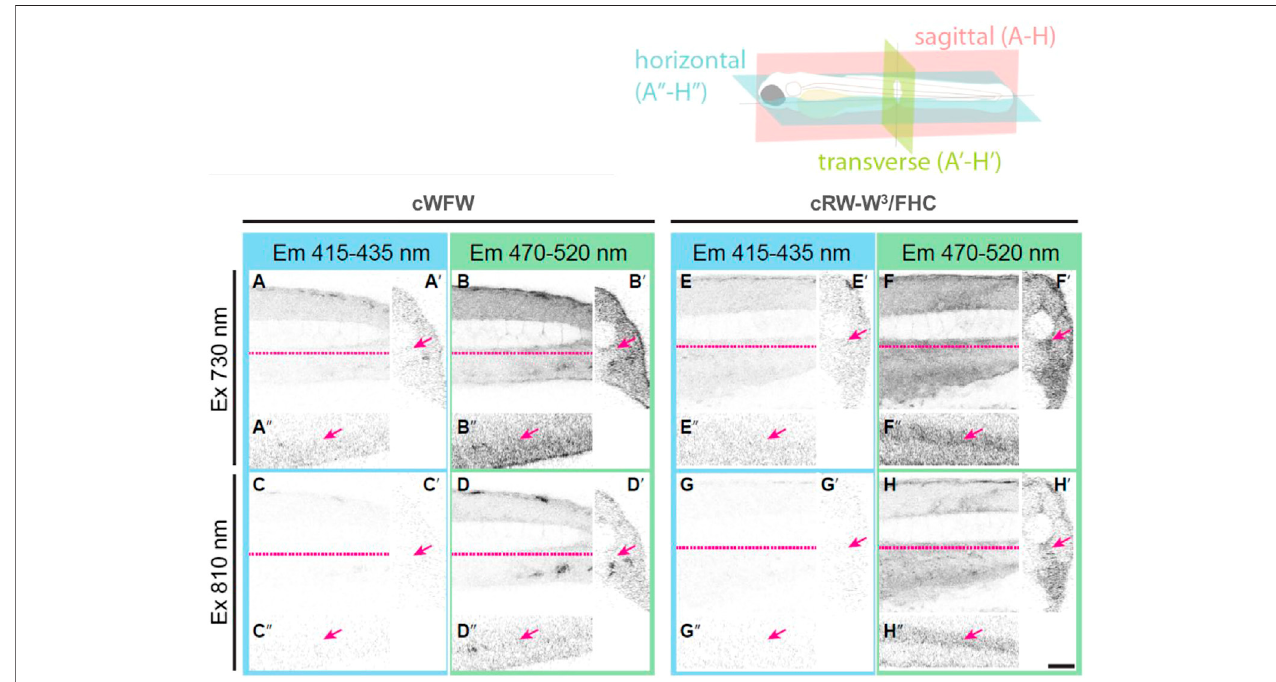
FIGURE 9 | Orthogonal section views from four dpf zebra fi sh embryos injected with either cWFW in PBS (A – D) or cRW-W 3 /FHC peptide (E – H) . The trunk region was imaged by detecting emitted fl uorescence light in a range of either 415 – 435 nm (A, C, E, G) or 470 – 520 nm (B, D, F, H) after sequential two-photon excitation at 730 nm (A,B,E,F) and810 nm (C,D,G,H) .Sagittalsections (A – H) ,transversesections (A 9 – H 9 ) andhorizontalsections (A 99 – H 99 ) areshown.Dashedlines(magenta)in sagittal views indicate the position where horizontal views were made. Arrows indicate the caudal artery, where cRW-W 3 /FHC and other peptides were mainly found to be localized. Scale bar: 50